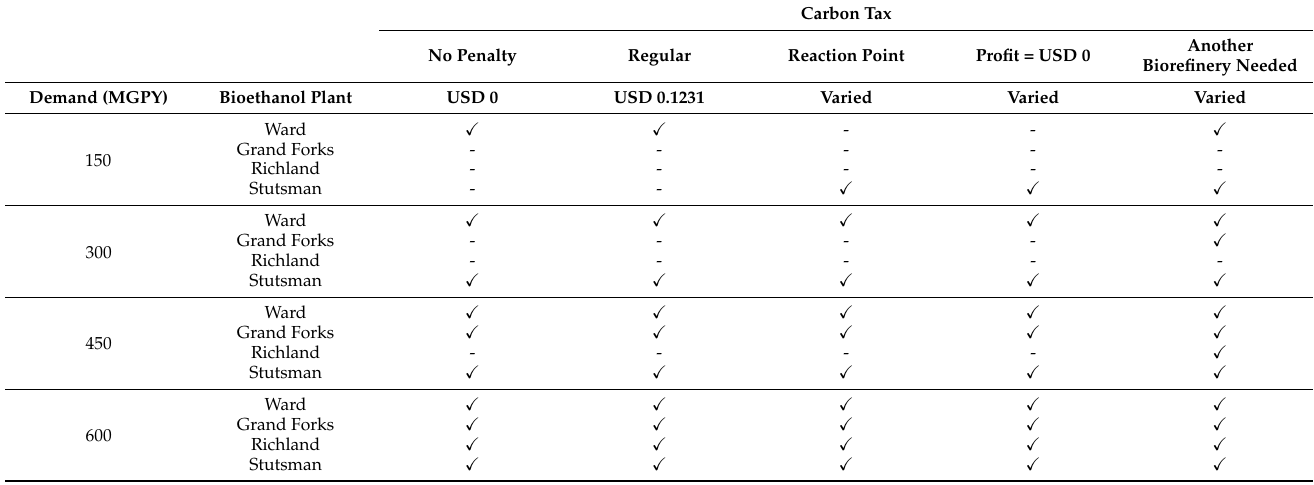
Table 5. Impact of different carbon taxes on bioethanol plant land allocation decisions.